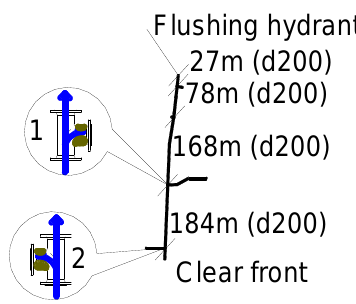
Figure 6. The section of CI pipe layout for site 1 (see Fig. 1). The locations of hydrant and fittings are indicated. The T-piece with reduction on right and left respectively to 100 mm is indicated under No. 1 and 2. The diameters of pipe segment in mm is shown in brackets.